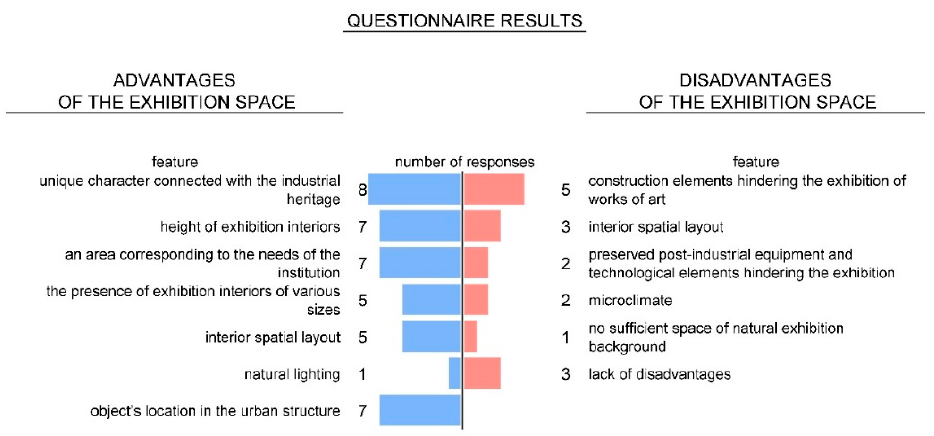
Figure 10. Questionnaire results; advantages and disadvantages of the exhibition space; authors’ work.